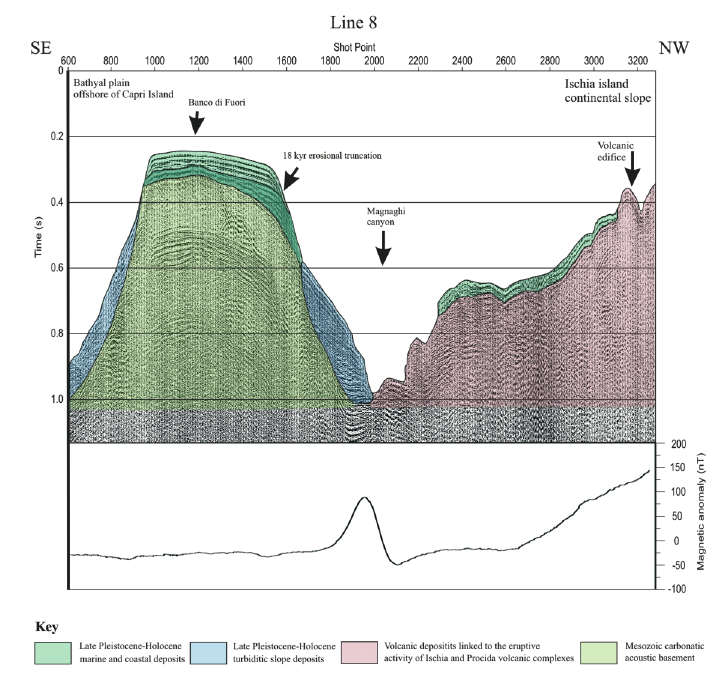
Fig. 8. Seismic profile GR85 and corresponding interpretation. The relative magnetic profile is reported in the inset. The flat trending of the magnetic anomaly in the Banco di Fuori structural high suggests that it could rep- resent a tilted block of Mesozoic carbonatic acoustic basement. A pronounced magnetic anomaly has been sin- gled out on the northwestern flank of the Magnaghi canyon, incised in the volcanic deposits of the Procida Is- land continental